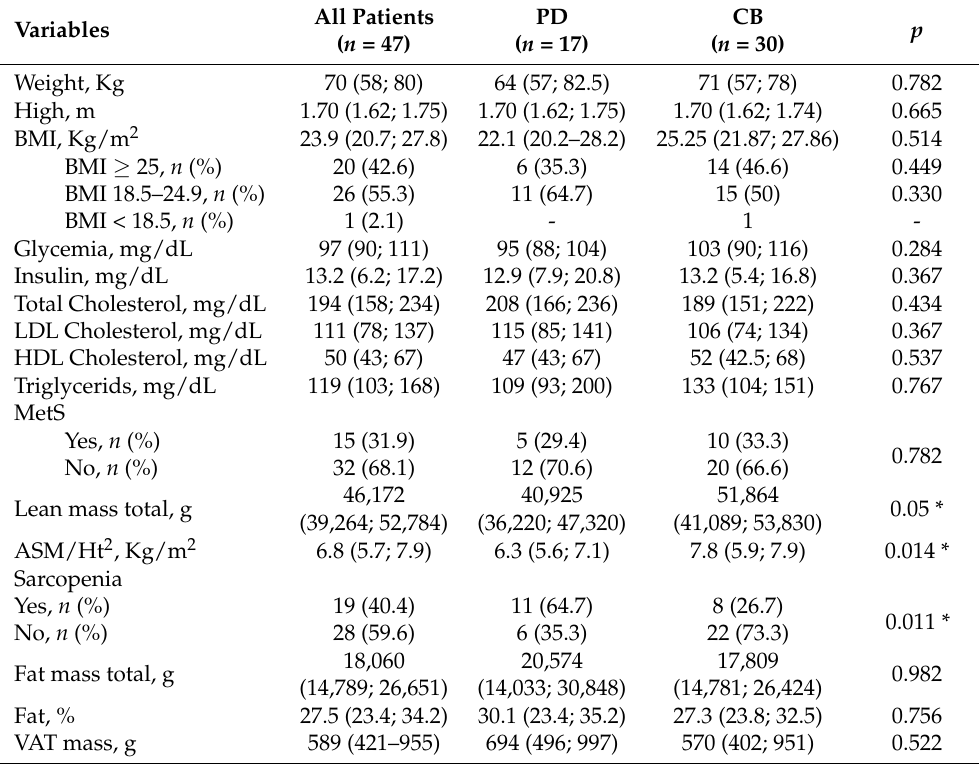
Table 2. Characteristic of metabolic and body composition parameters. Data of all patients ( n = 47) are reported and a comparison between PD ( n = 17) vs. CB ( n = 30) groups. Values are expressed in median (IQR). Mann–Whitney U test was used d for continuous variables. Chi-squared was used for non-continuous variables (* p < 0.05).